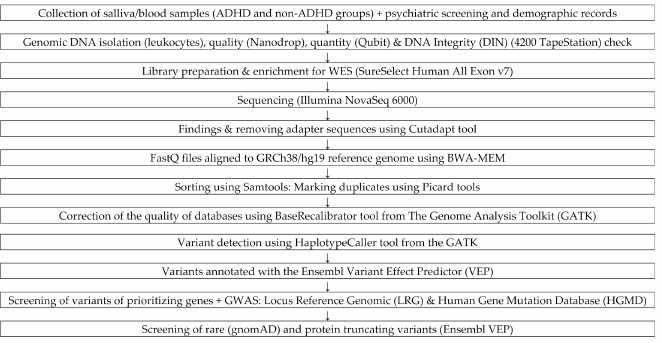
Figure 1. Diagram of WES Sequencing: laboratory experiment and bioinformatics